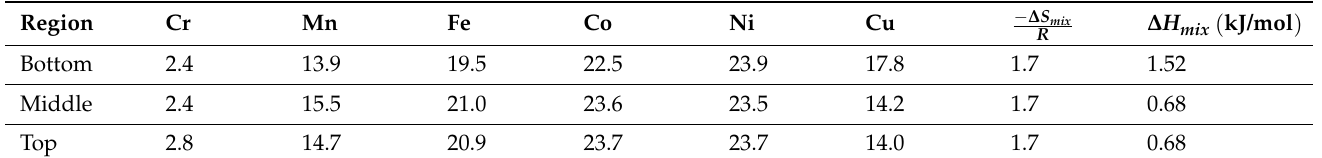
Table 6. Review of regional compositions (at.%) taken from the bottom, middle, and top zones of samples; respective thermodynamic parameters are also listed.